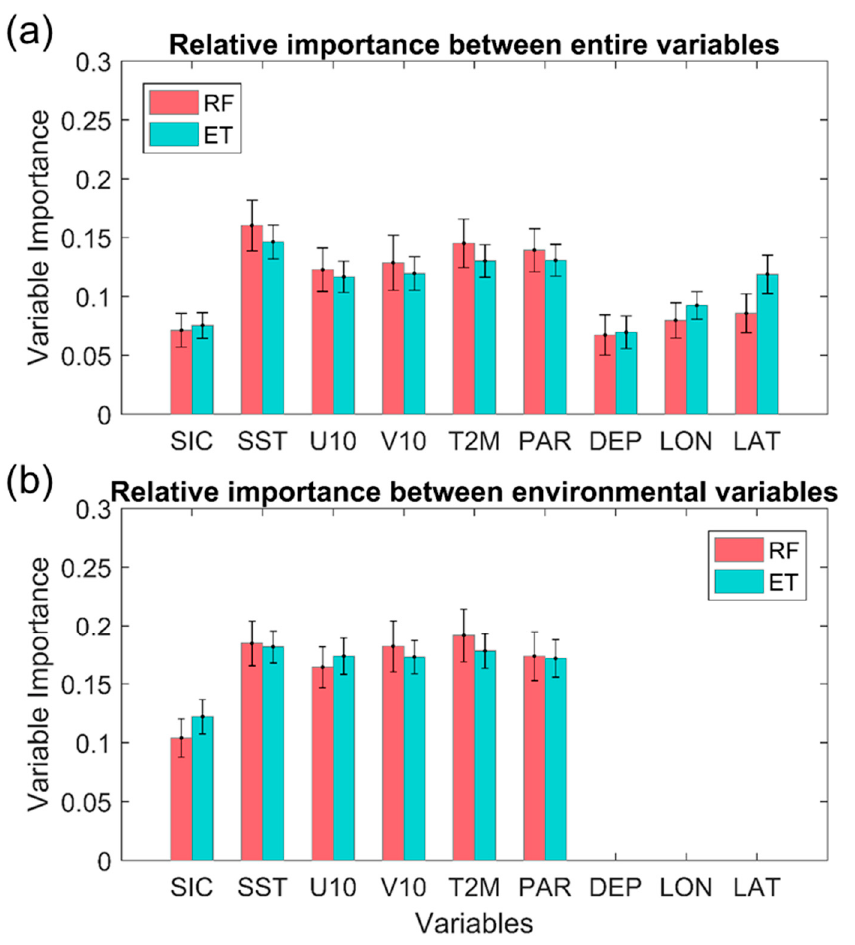
Figure 8. The relative importance of variables in the RF (light red) and ET (light blue) models using: ( a ) all variables; and ( b ) only environmental variables.